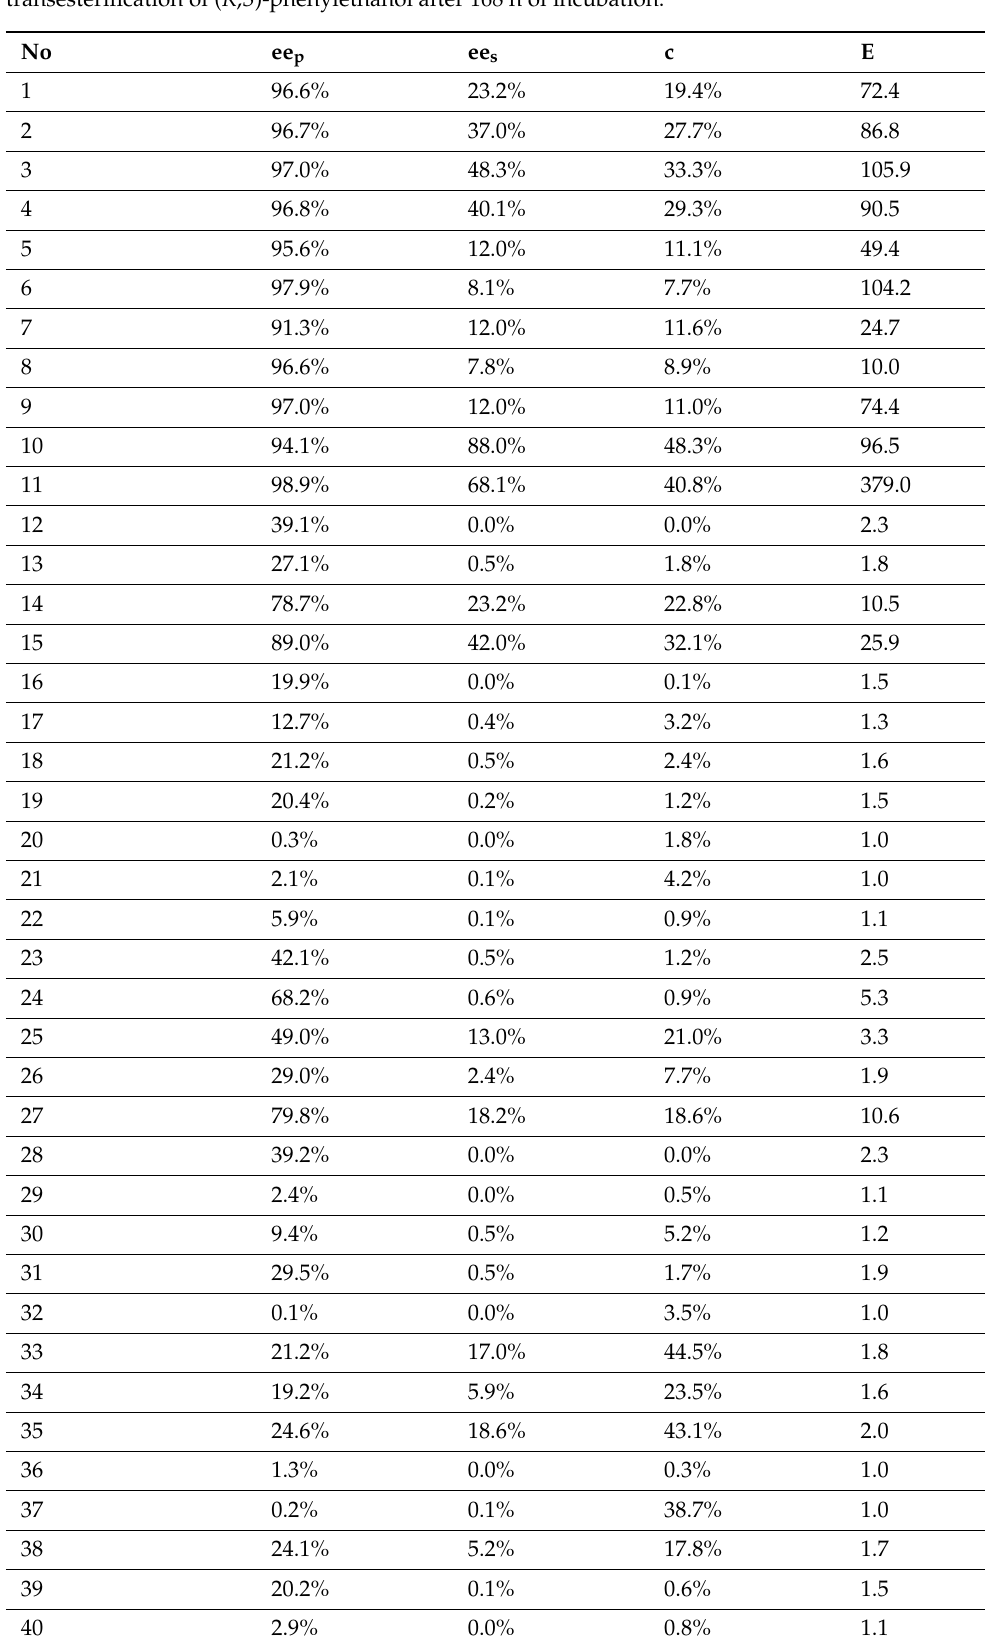
Table 2. Enzymatic parameters including enantiomeric excesses of products (ee p ) and substrates (ee s ), conversion (c), and enantioselectivity (E) of different reaction systems screened for the enantioselective transesterification of ( R , S )-phenylethanol after 168 h of